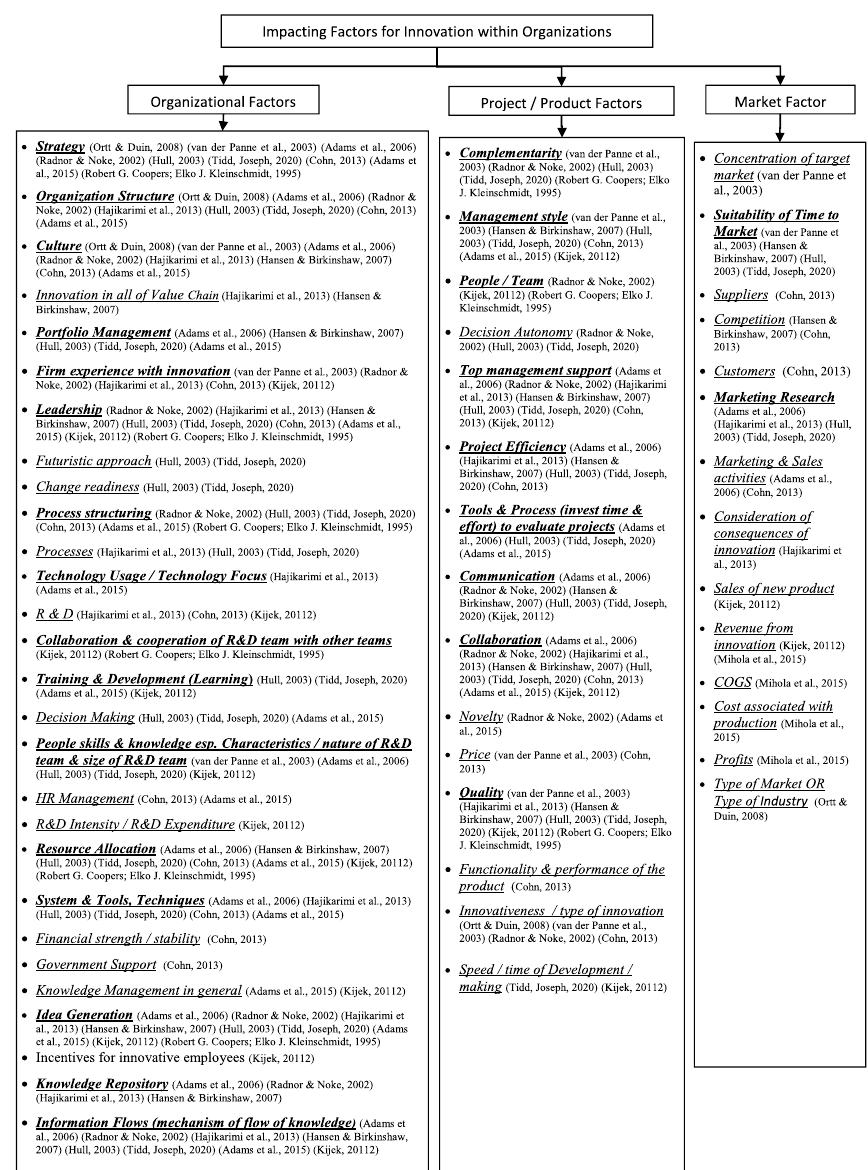
Fig. 2 Factors impacting innovation identified through literature